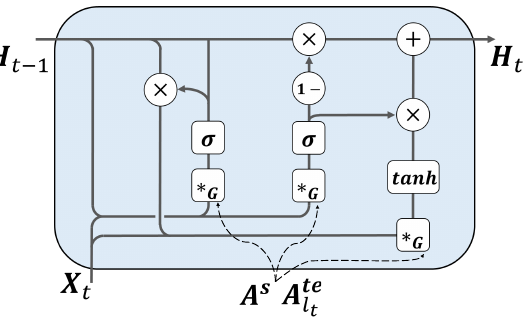
Figure 4. The structure of time-evolving graph convolutional gate recurrent